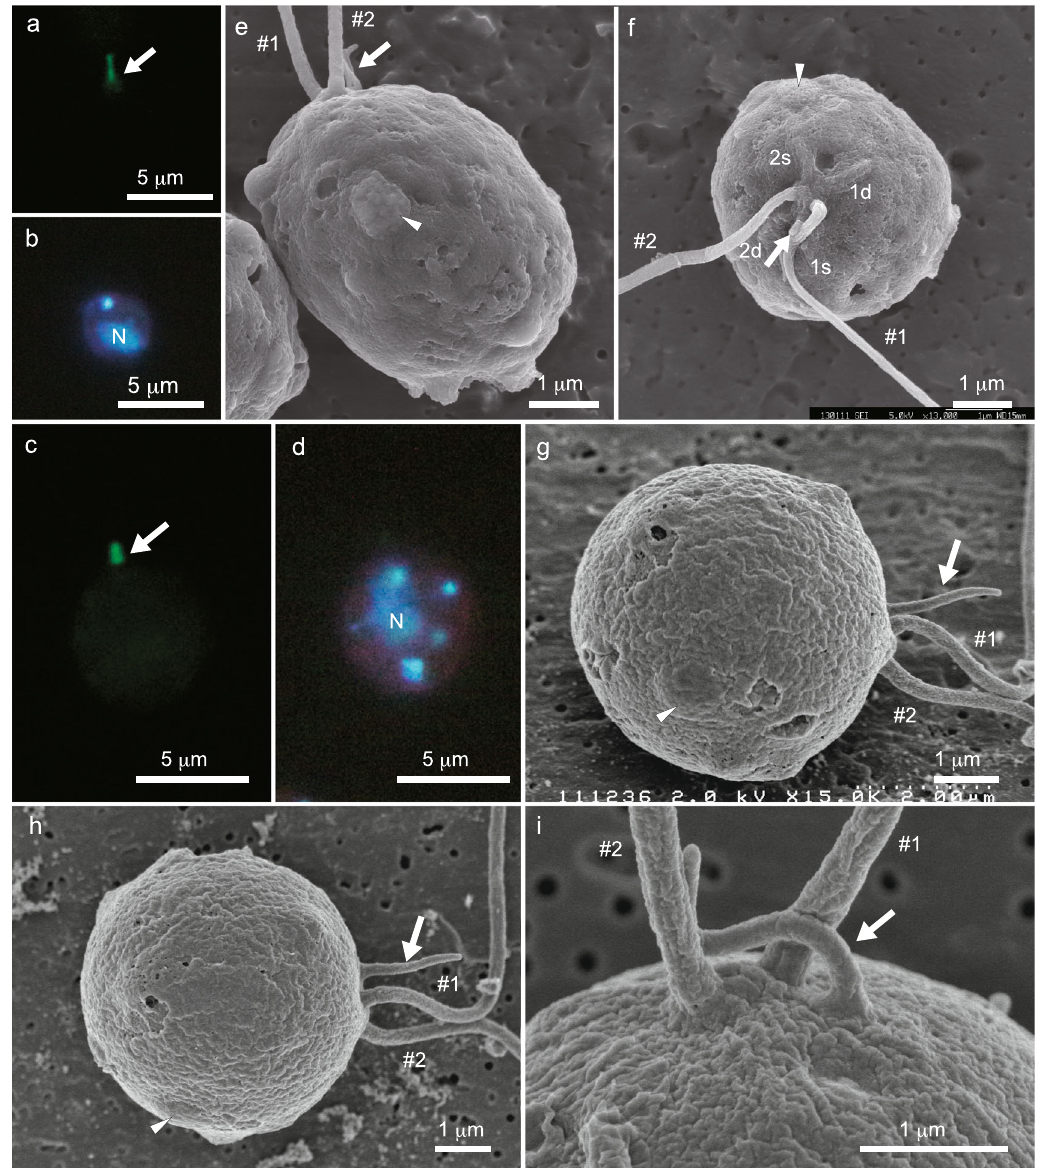
Fig. 2 Localisation of the fertilisation tubule and eyespot in wild-type CC-125 (mt + ) and mating type-reversed CC-3712 (mid mt – ) gametes. The fertilisation tubule and nucleus were reacted with an anti-actin antibody ( a , c ) and DAPI ( b , d ), respectively. Spatial positioning of the fertilisation tubules and eyespots was visualised by FE-SEM ( e – i ). a , b Wild-type mt + gamete. The fertilisation tubule was elongated from the cell apex. c , d CC-3712 gamete. The fertilisation tubule was extended from the cell apex. e Side view of the wild-type mt + gamete. The fertilisation tubule was present on the side of the beat plane opposite the eyespot. f Top view of the wild-type mt + gamete. The fertilisation tubule was situated on the intersection point of the two lateral ridges overlying the 1s and 2d roots. g Side view of the CC-3712 gamete. h Tilted image of g . The fertilisation tubule was present on the side of the beat plane opposite the eyespot. i Enlarged image of the cell anterior of a CC-3712 gamete. The fertilisation tubule was elongated from the fl agellar base close to the #1 fl agellum. Arrows and arrowheads indicate fertilisation tubules and eyespots, respectively. #1 : no. 1 fl agellum, #2 : no. 2 fl agellum, 1d, 1s, 2d and 2s : lateral ridges overlying 1d, 1s, 2d and 2s microtubular roots, respectively, N :